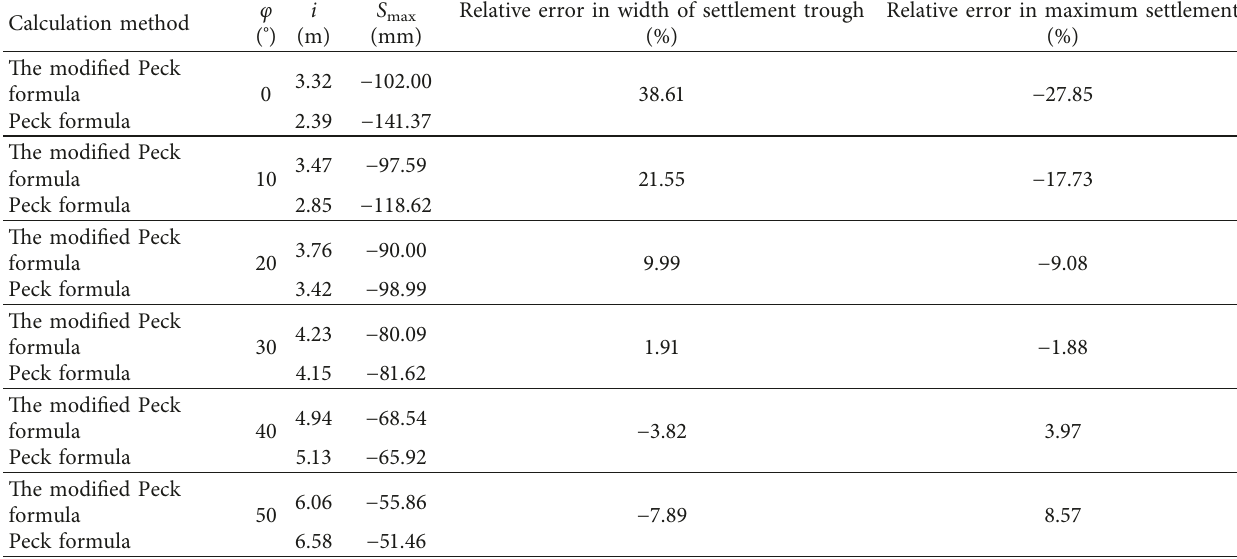
Table 4: The relevant parameters of the settlement curve of each internal friction angles φ